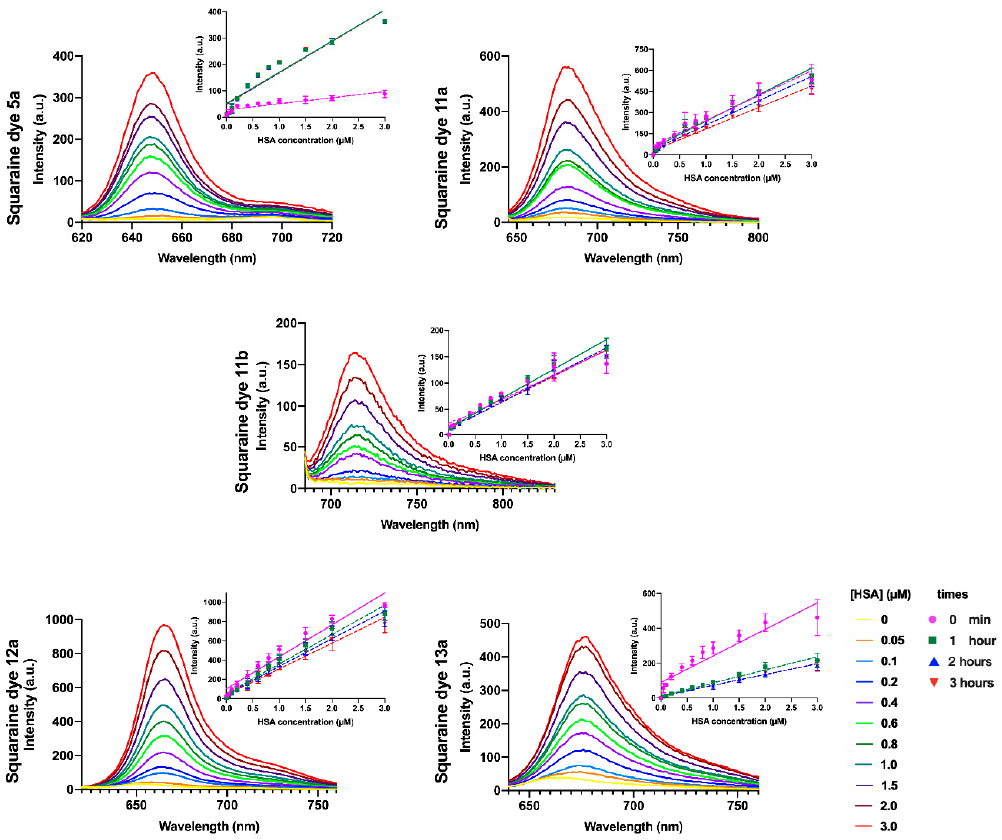
Figure 2. Fluorescence spectra of the squaraine dyes ( 5a , 11a , b , 12a , and 13a ) on phosphate buffer pH 7.4, with increasing concentrations of human serum albumin (0.00, 0.05, 0.10, 0.20, 0.40, 0.60, 0.80, 1.00, 1.50, 2.00 and 3.00 µM) and regression plots of the emitted fluorescence intensity as a function of protein concentration at various incubation times (t = 0, 1, 2 and 3 h). Data on the plots are the mean ± standard deviation of three independent assays. Spectra presented correspond to the time in which the dye exhibited more expressive fluorescence intensity in the shortest required time (full line). Fluorescence intensity is presented as arbitrary units (a.u.).